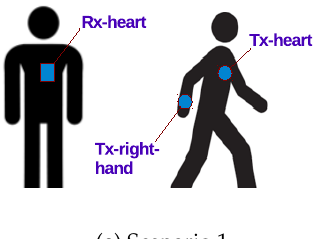
Figure 7. Scenario 1: walking line-of-sight (LOS)/non-line-of-sight (NLOS) Rx-heart/Tx-right-hand. Scenario 2: rotation Rx-heart/Tx-heart. Table 4. BBN scenarios of the wireless signal propagation in outdoor